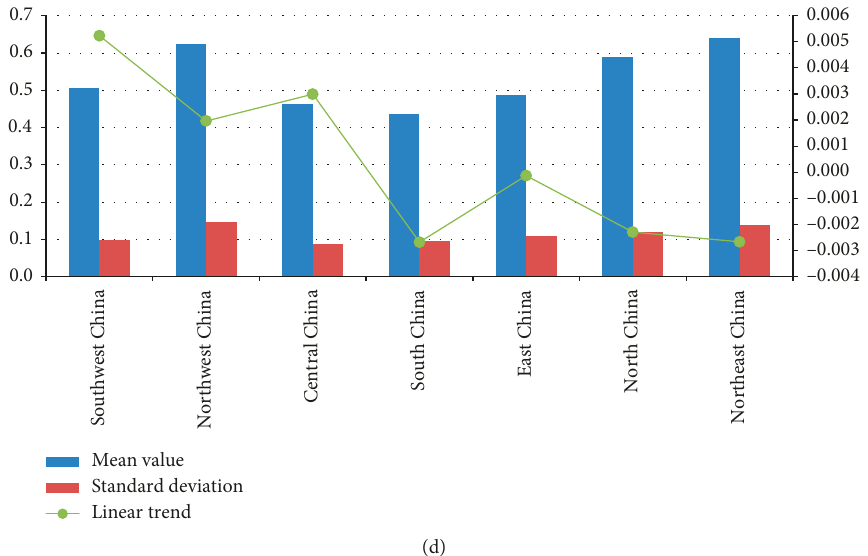
Figure 3: Temporal variation and spatial distribution of China’s vegetative PUE from 2000 to 2015. (a) Spatial distribution of the multiyear mean value of China’s vegetative PUE. (b) Standard deviation of China’s vegetative PUE. (c) Linear trend of China’s vegetative PUE. (d) Statistical central tendency of the mean value, standard deviation and linear trend of China’s vegetative